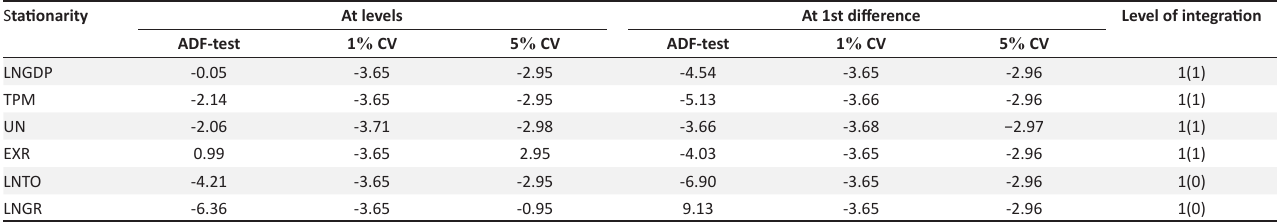
TABLE 2: Unit root.